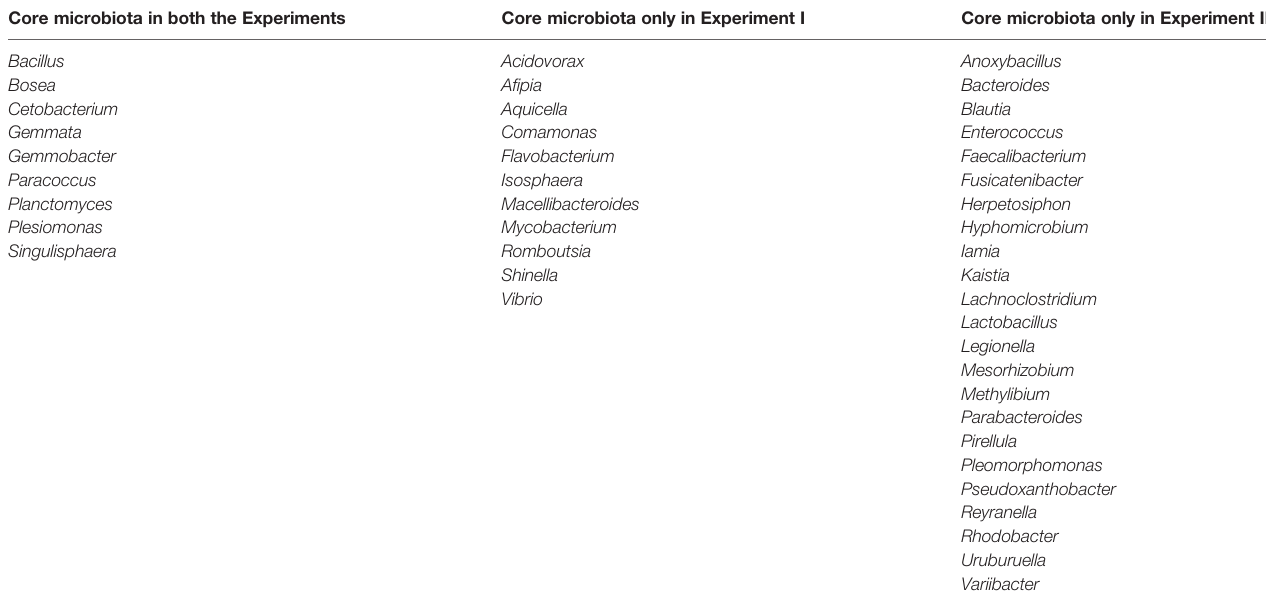
TABLE 2 | Core microbiota of the intestine of larval and juvenile tilapia at the genus